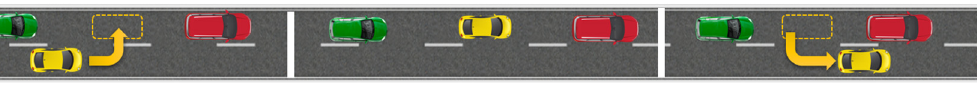
Figure 11. Concept demonstration of scenario 2.